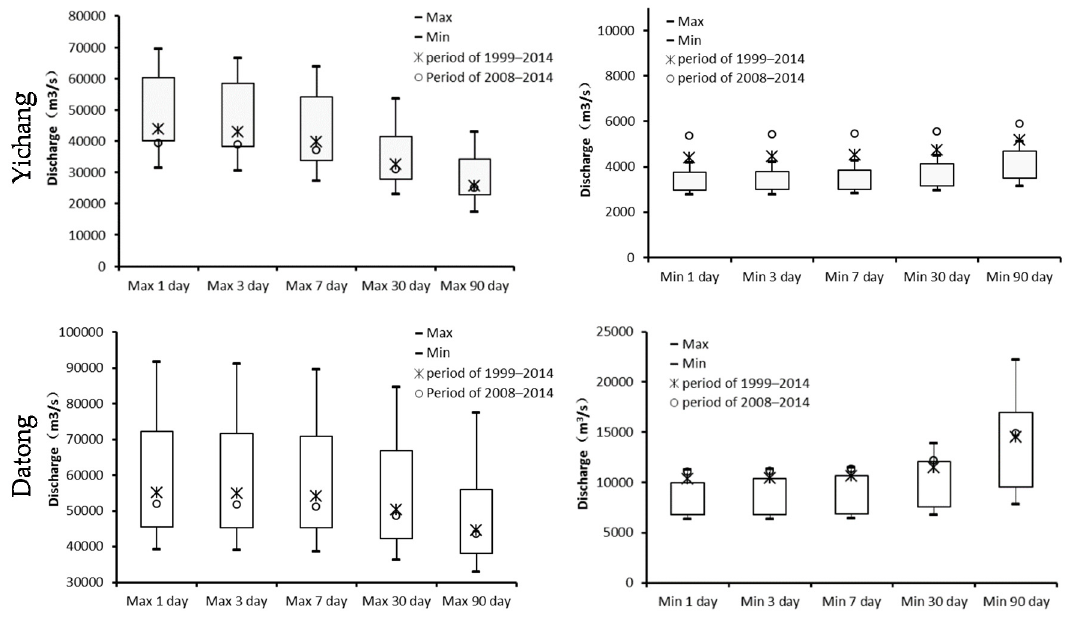
Figure 8. The maximum and minimum values between natural and observed flow series during 1999–